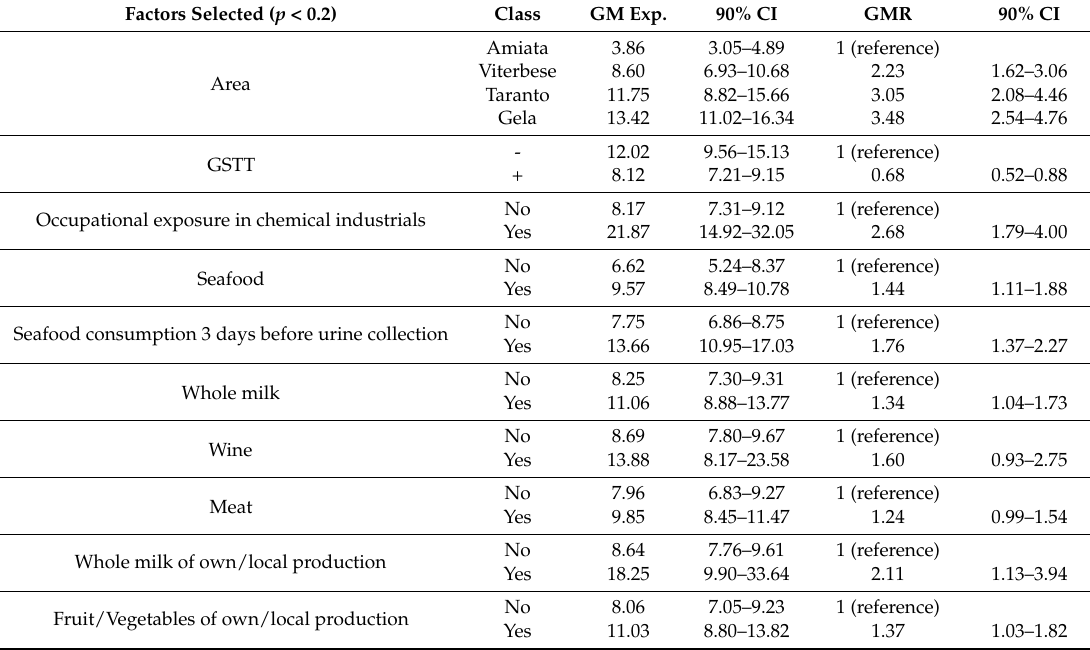
Table 3. Overall sample. Factors associated with u(iAs+MMA+DMA) concentration by stepwise multivariate regression